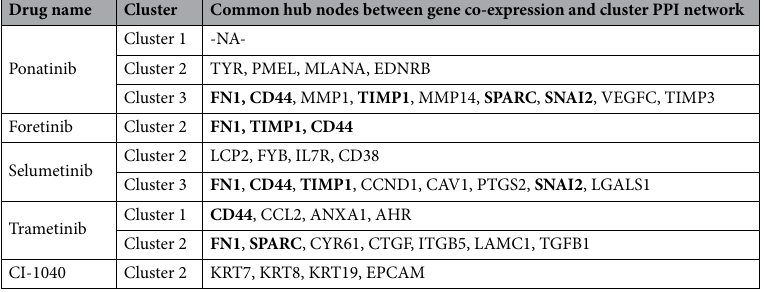
Table 2. List of common hub nodes between gene co-expression and PPI network for each five